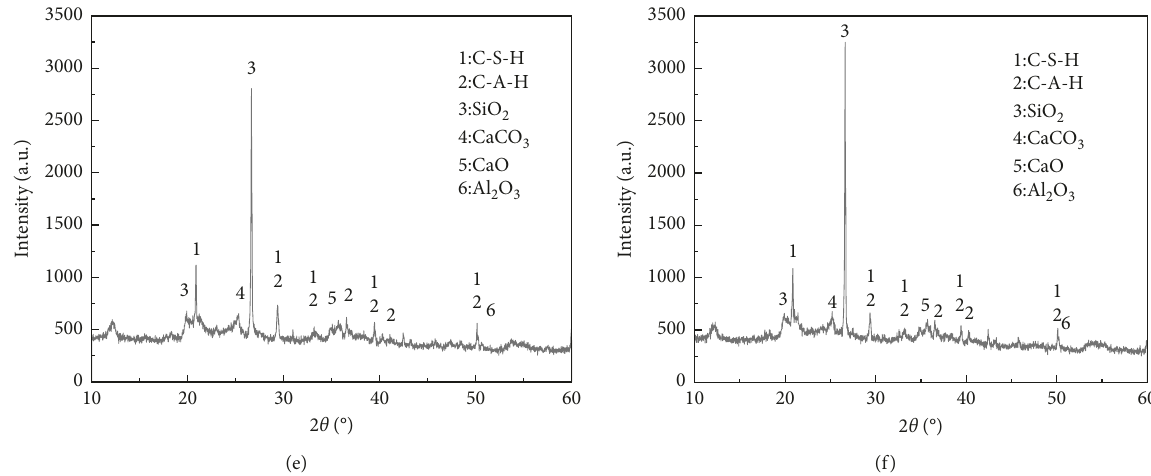
Figure 10: X-ray diffraction pattern. (a) Undisturbed soil. (b) 5% cement ratio. (c) 10% cement ratio. (d) 15% cement ratio. (e) 20% cement ratio. (f) 25% cement ratio.